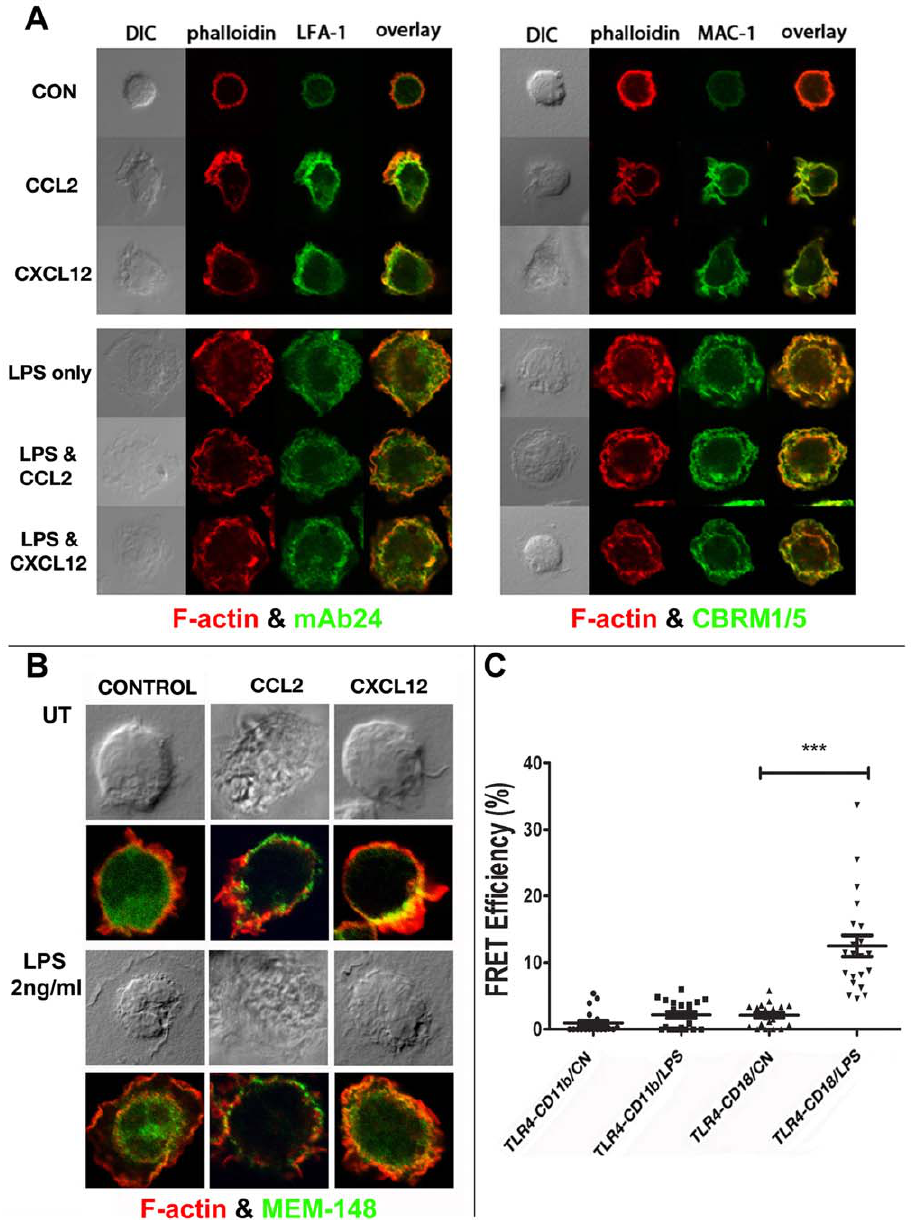
Figure 5. LPS treatment induced global activation of LFA-1 and Mac-1 in human monocytes, which was not reversed by chemokine stimulation. A ) Human monocytes on cover slips were incubated with (LPS) or without (CON) LPS at 2 ng/ml for 15 min at 37 u C. Cells were then washed and treated with CCL2 or CXCL12 (20 nM) for 2 min at 37 u C. Cells were fixed, permeablized and stained with phalloidin-568 and murine mAbs against ß2 integrin activation epitopes in LFA-1 (mAb24, left) or Mac-1 (CBRM1/5, right) followed by Alexa-488 conjugated anti-mouse IgG. B ) Cells treated as described above were stained with phalloidin-568 and mAb MEM148 (followed by Alexa-488 conjugated anti-mouse IgG), which recognizes ß2 integrin activation epitope, irrespective of the heteromeric context. Individual channels corresponding to phalloidin and integrin staining and composite 2-color images are shown along with DIC images. C ) Acceptor photobleaching FRET assay of proximity interaction between TLR4 and integrins. Human monocytes on cover slips treated with or without LPS (2 ng/ml) for 15 min were fixed and stained with biotin conjugated anti-TLR4 HTA-125 mAb (TLR4) and MEM148 mAb against a b 2-integrin activation epitope (CD18) or CBRM1/5 mAb against activated Mac-1 (CD11b), followed by staining with Alexa-488 steptavidin and Alexa-568 goat anti-mouse IgG. FRET was performed in a Leica TCS SP5 confocal microscope. Photo-bleaching was performed with high-intensity laser scanning at 514 nm at 100% power output in defined ROIs (regions of interest). Pre- bleaching and post-bleaching images were acquired, and the average fluorescence intensity of both donor (Alexa-488) and acceptors (Alexa-568) in the bleached ROIs were measured using the proprietary Leica acceptor photobleaching program. E f =(I post 2 I pre )/I pre calculated FRET efficiency (E f ), where I corresponds to average intensity of donor (Alexa-488). FRET values averaged from , 6 ROIs in each of the 6–10 cells from each of 3 separate experiments with different donor cells are plotted in the graph with the mean and standard error drawn as box and whiskers (n=3, *** p , 0.01).